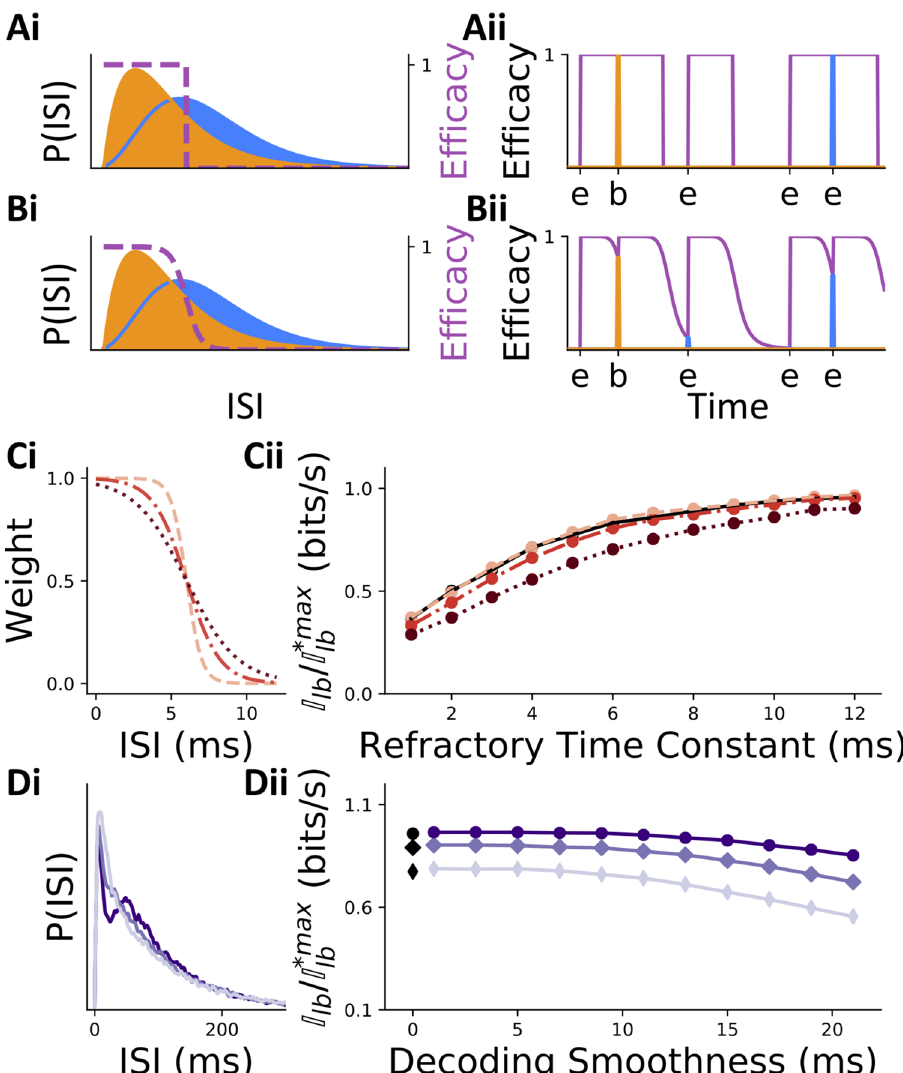
Figure 4. Properties of dynamic synapses influence information transmission. ( A, B ) Bursts and events can be decoded by either sharp ( A ) or smooth ( B ) dependence of the synaptic efficacy on the interspike interval. ( Ai–Bi ) IBI (orange) and IEI (blue) distributions are overlayed on the function relating interspike intervals to synaptic efficacy (purple, right axis). ( Aii–Bii ) The effect of this function on the decoded modulator signal is illustrated using a single hypothetical spike train with true events (ticks labeled by ‘e’) and true intra-burst spikes (ticks labeled by ‘b’). The strength at which an incoming spike will be read out is represented by the height of the blue and orange vertical lines (event = blue; intraburst = orange), whose heights are themselves decided by the momentary synaptic efficacy (purple line), which changes in time as a function of spike history. ( Ci ) Three instances of graded sensitivity to the firing frequency. ( Cii ) Modulator information transmission is shown against the refractory time constants around the liminal regime for the three nonlinear sensitivity functions shown in Bi (same colour and line-style schemes—rate compensated data shown). Black line (obscured behind yellow) gives sharp threshold-based communication for comparison. ( Di ) ISI distributions (smoothed with Gaussian filter) for three different relative refractory period time constants: 5 ms (light purple), 8 ms (purple), 12 ms (dark purple). ( Dii ) Modulator information transmission as a function of the sensitivity to firing frequency for the three ISI distributions pictured in ( iii ) (same colour scheme). Black dots denote sharp threshold- based communication. All data for variable τ rel is rate corrected, as in Fig. 3C, and data for sharp threshold communication is taken from Fig.